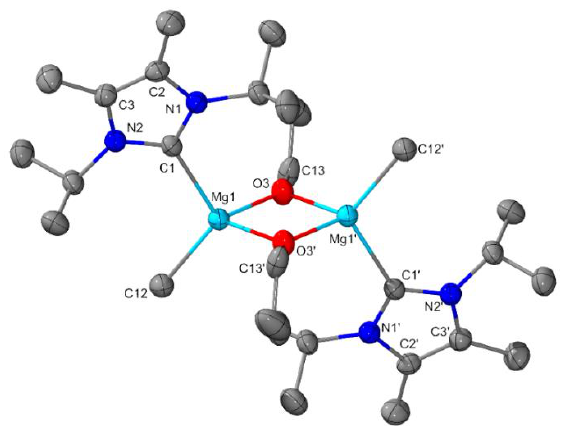
Figure 5. Molecular structure of 5 (thermal ellipsoids at 50% probability; H atoms omitted for clarity). Selected bond distances (Å) and angles (°): N1−C1: 1.361(2); N2−C1: 1.362(3); Mg1−C12: 2.160(2); Mg1−O3: 1.9761(16); Mg1−O3: 1.9903(16); Mg1−C1: 2.299(2); C2−C3: 1.352(3); N1−C2: 1.395(3); N2−C3: